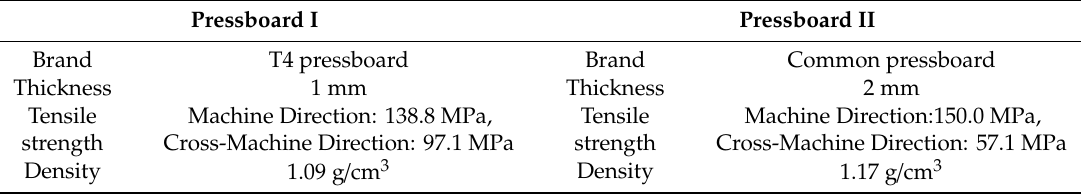
Table 5. Details of two types of cellulosic pressboards.